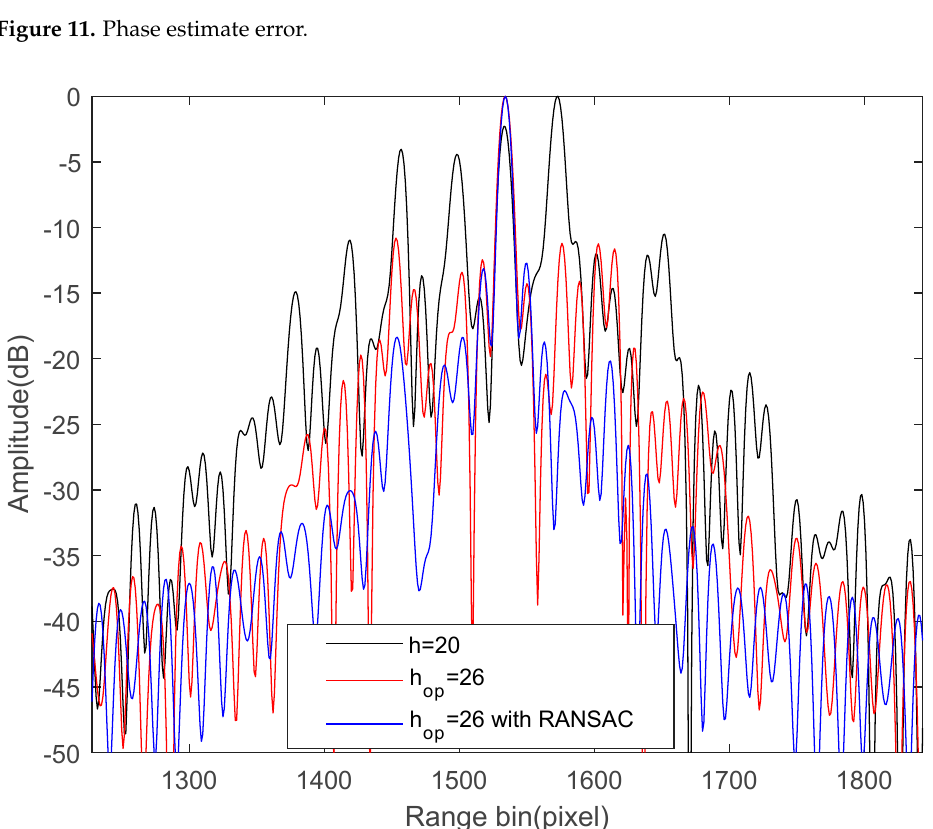
Figure 12. Quality evaluation diagram of multi-component compensation.